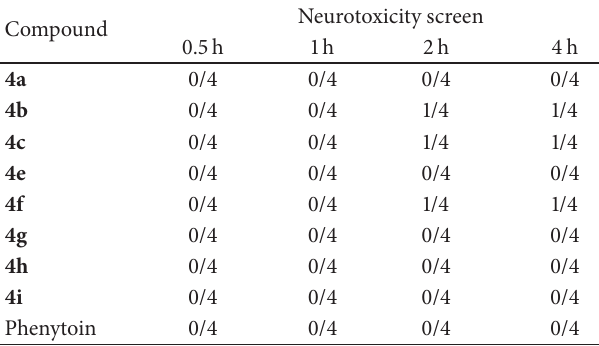
Table 2: Effect of the tested compounds in the maximal electro- shock seizure test.